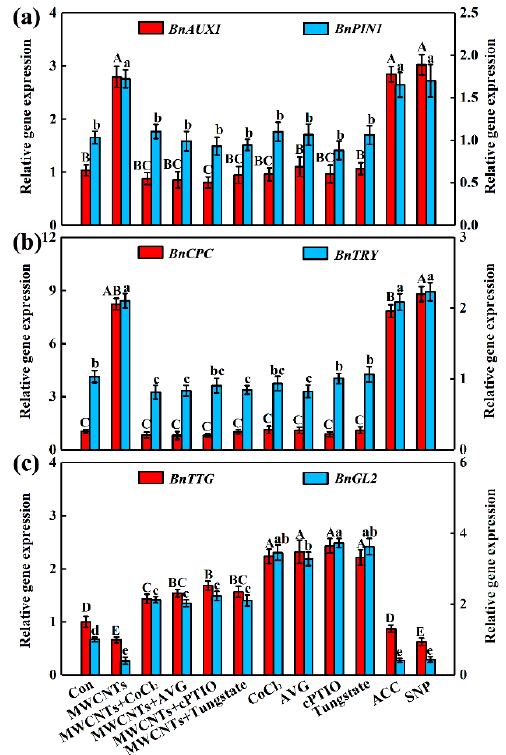
Figure 5. The transcripts levels of root hair development-related genes. Two-day-old rapeseed seedlings were treated with 100 mg/L MWCNTs, 10 μ M CoCl 2 , and 3 μ M AVG, 100 μ M cPTIO, 100 μ M tungstate, 3 μ M ACC, and 20 μ M SNP, alone or in combinations for 24 h. Afterward, BnAUX1 and BnPIN1 ( a ), BnCPC and BnTRY ( b ), and BnTTG and BnGL2 ( c ) transcriptional levels were analyzed by qPCR. The sample without chemicals was the control (Con). Within each set of experiments, bars with different letters are significantly different at p < 0.05, according to Duncan’s multiple range test.